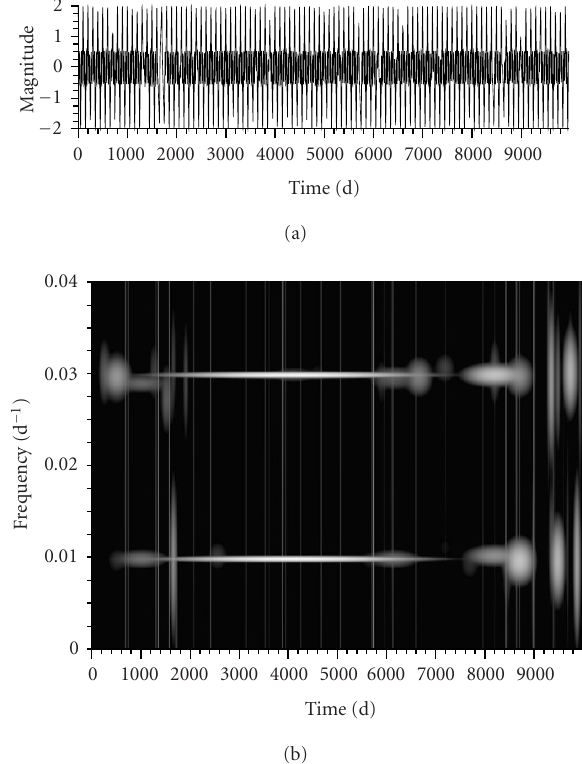
Figure 11: Time-frequency decomposition (b) of the simulated sig- nal (a) made from the AC Herculis sampling. Each grey level repre- sents the energy density of each